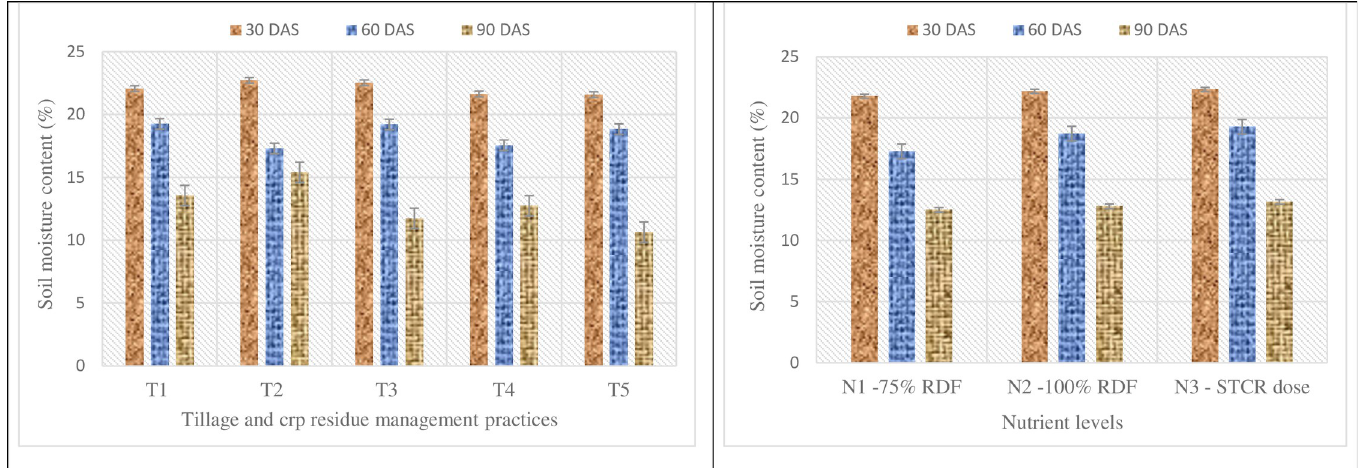
Fig 2. Effect of tillage practices, crop residue management and nutrient levels on soil moisture content. (T 1 —NT with 30cm residue height; T 2 —NT with 60cm residue height; T 3 —RT with 30cm residue height; T 4 —RT with 60cm residue height; T 5 –Conventional